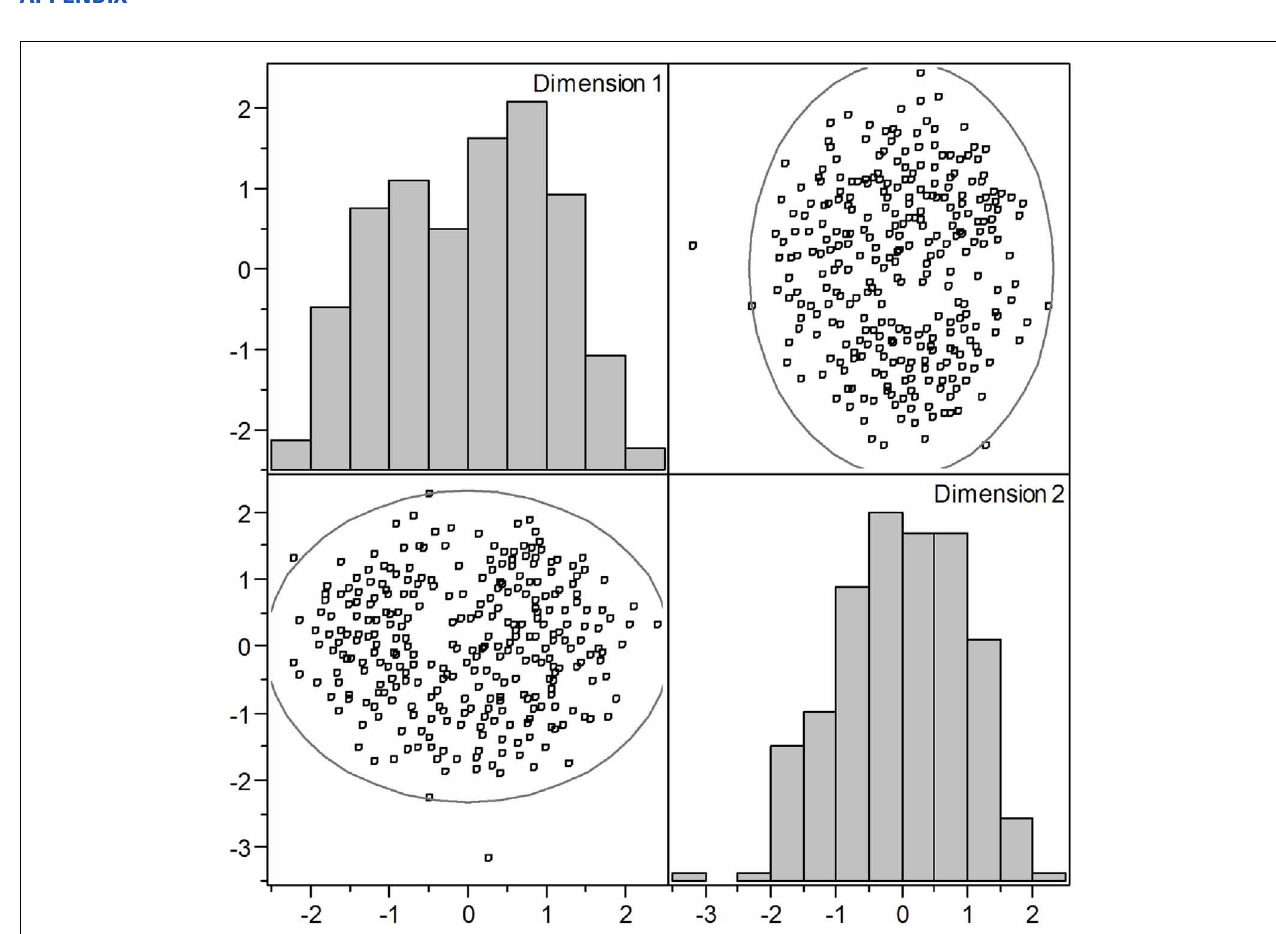
FIGUREA1 | Multidimensional scaling (MDS) analysis of an identity by state (IBS) of pig samples clustering showed that population stratification is not prominent